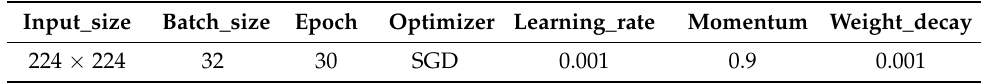
Table 2. Hyperparameter settings during model training.